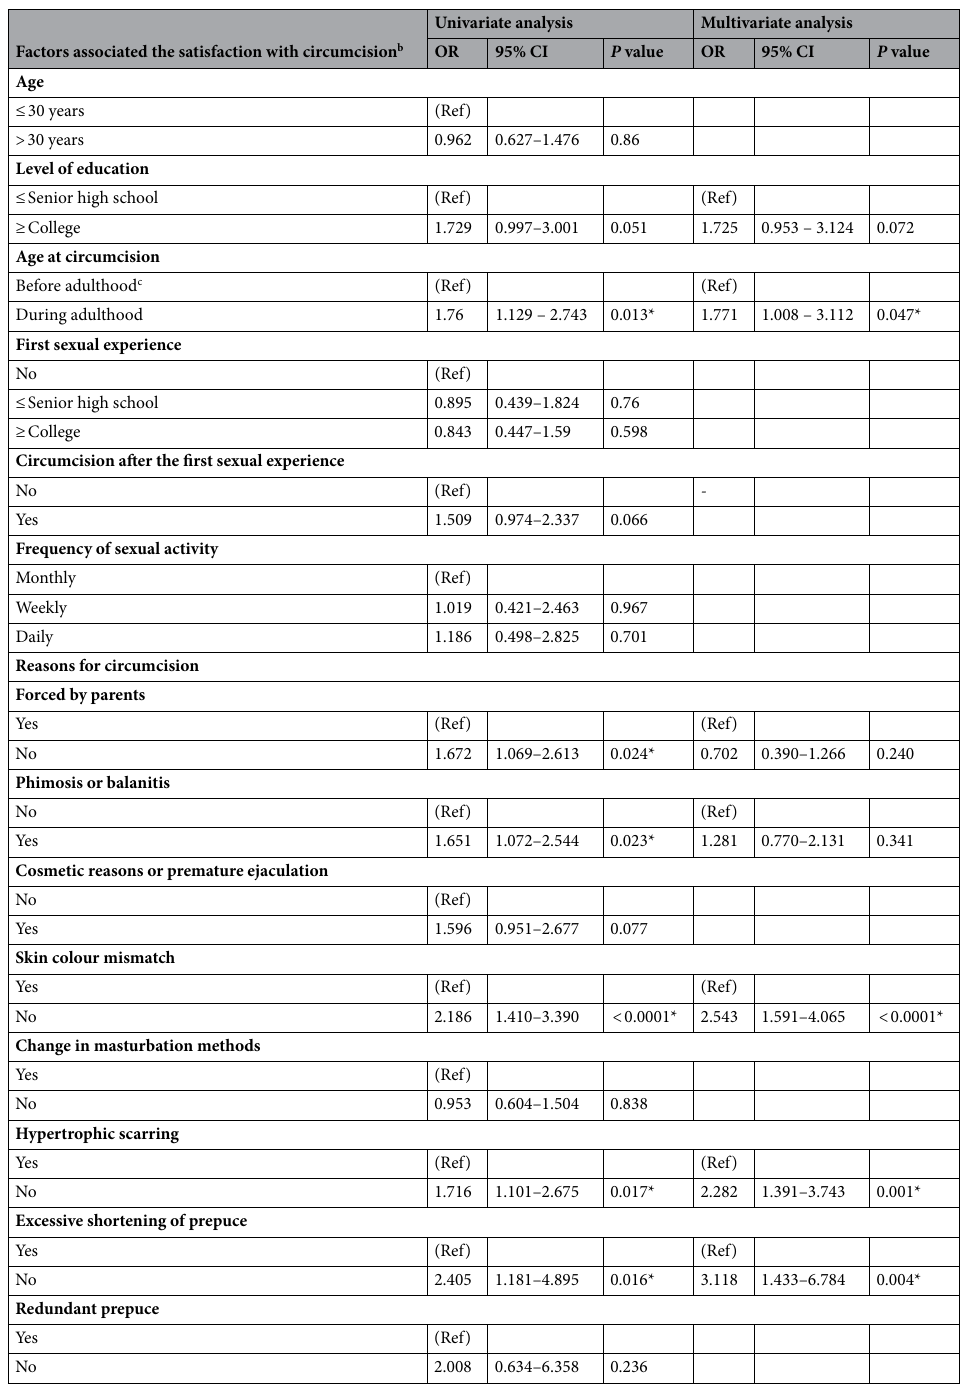
Table 2. Comparative univariate and multivariate logistic regression analyses for the factors associated with satisfaction with circumcision. a OR odds ratio, CI confidence interval. * p < 0.05. a Logistic regression test was calculated for the difference in factors associated with satisfaction with circumcision. b Factors showed a difference in the univariate logistic regression test included in multivariate logistic regression. The level of education with p = 0.051 is closed to the definition of significance and showed a difference in the chi-square test, so we enrolled this factor in multivariate logistic regression. c Adulthood means over 20 years